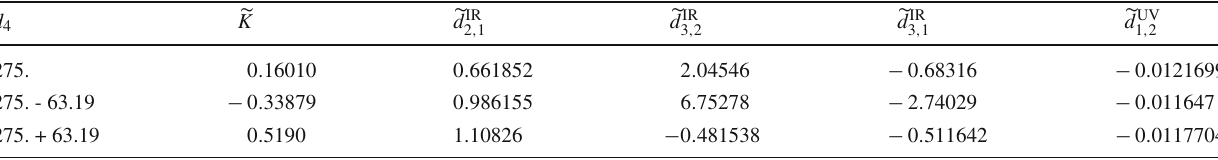
Table 1 The values of (cid:3) K and of the renormalon residues (cid:3) d X according to Eq. (23)